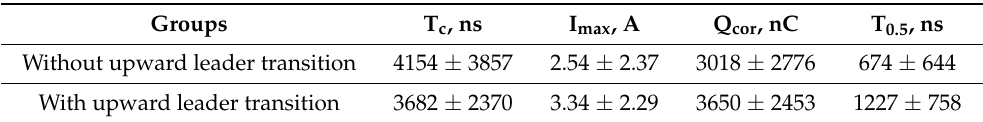
Table 2. Characteristics of the first pulsed streamer corona flash for experiments with elements simulating extended tubular objects of various radii.